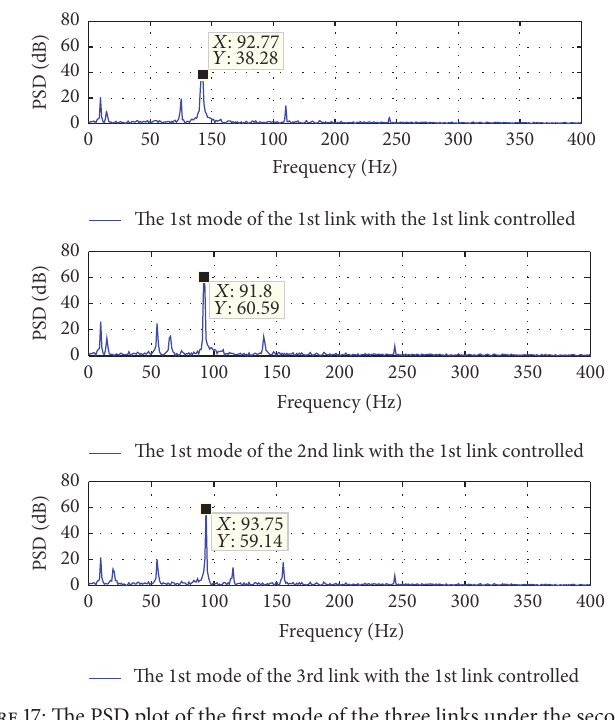
Figure 17: The PSD plot of the first mode of the three links under the second case.